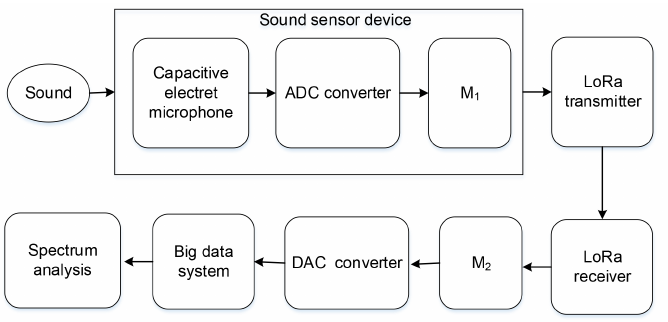
Figure 5. The architecture of sound spectrum